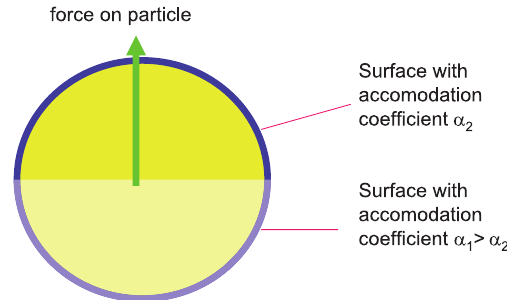
Fig. 7 Photophoretic Δ α force. A particle, hotter than the sur- rounding air, has a larger accommodation coefficient on the lower hemisphere. Consequently the molecules reflected by the lower hemisphere are faster than the ones on the upper hemisphere, resulting in an upward-directed